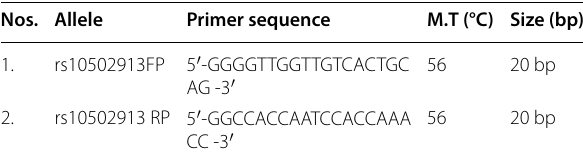
FP, forward primer; RP, reverse primer; M.T, melting temperature